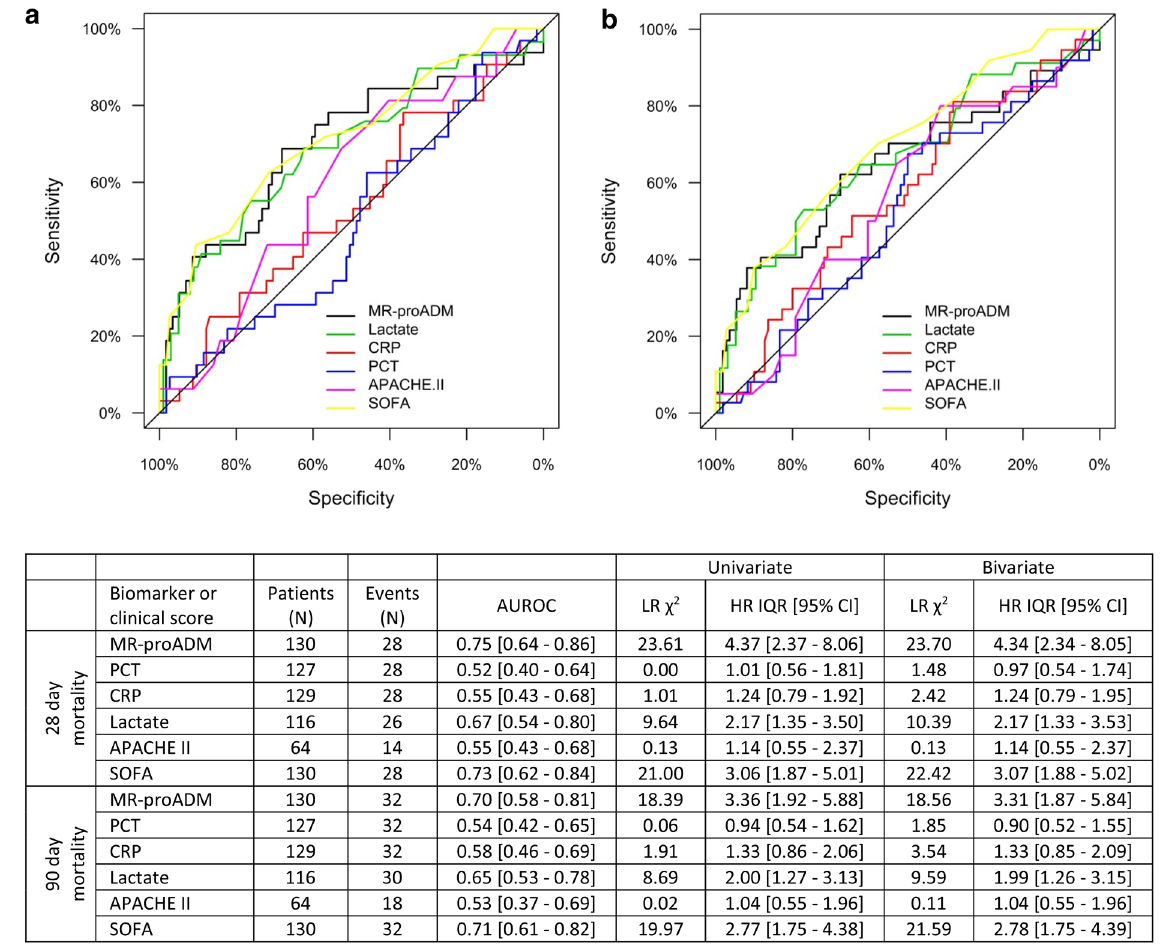
Fig. 2 AUROC, univariate and bivariate analysis for the prediction of 28‑day a and 90‑day b mortality for each biomarker and clinical score. APACHE II Acute Physiological and Chronic Health Evaluation II score, AUROC area under the receiver operating characteristic curve, CI confidence interval, CRP C‑reactive protein, HR hazard ratio, IQR interquartile range, LR likelihood ratio, MR ‑ proADM mid‑regional proadrenomedullin, N number, PCT procalcitonin, SOFA Sequential Organ Failure Assessment